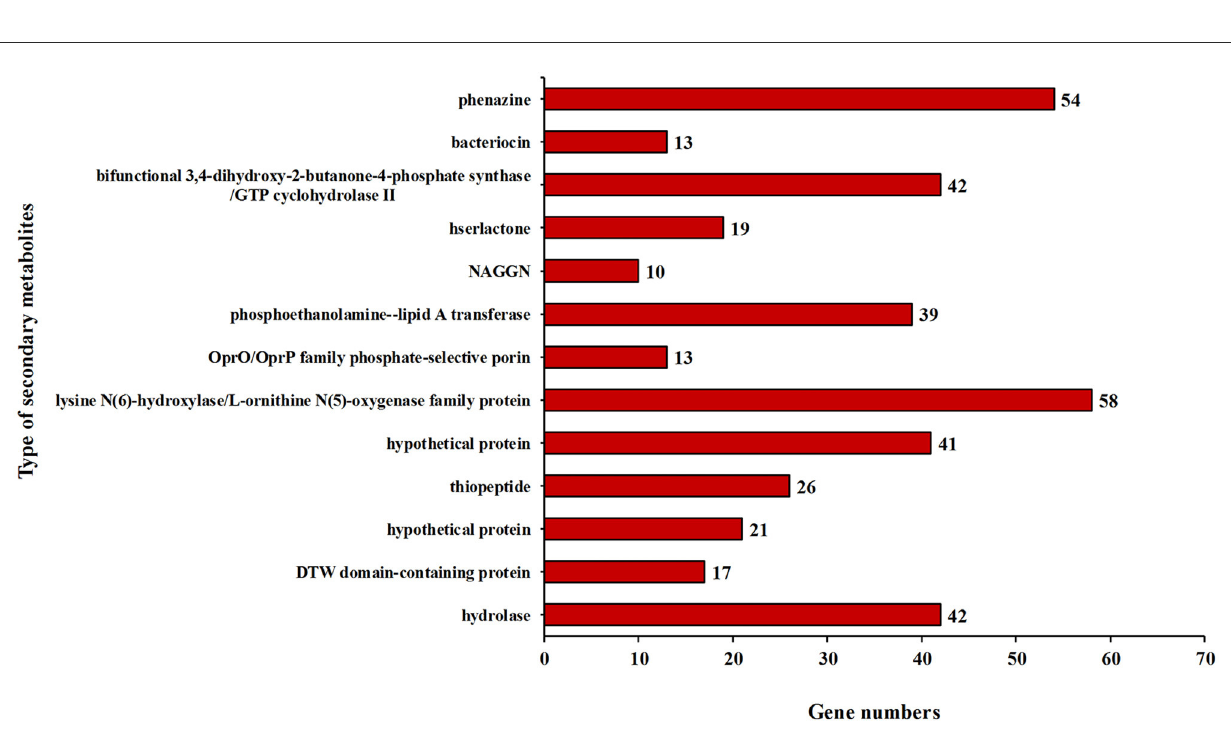
FIGURE4 Secondary metabolic gene clusters in the genome of strain Pseudomonas aeruginosa DJ06.